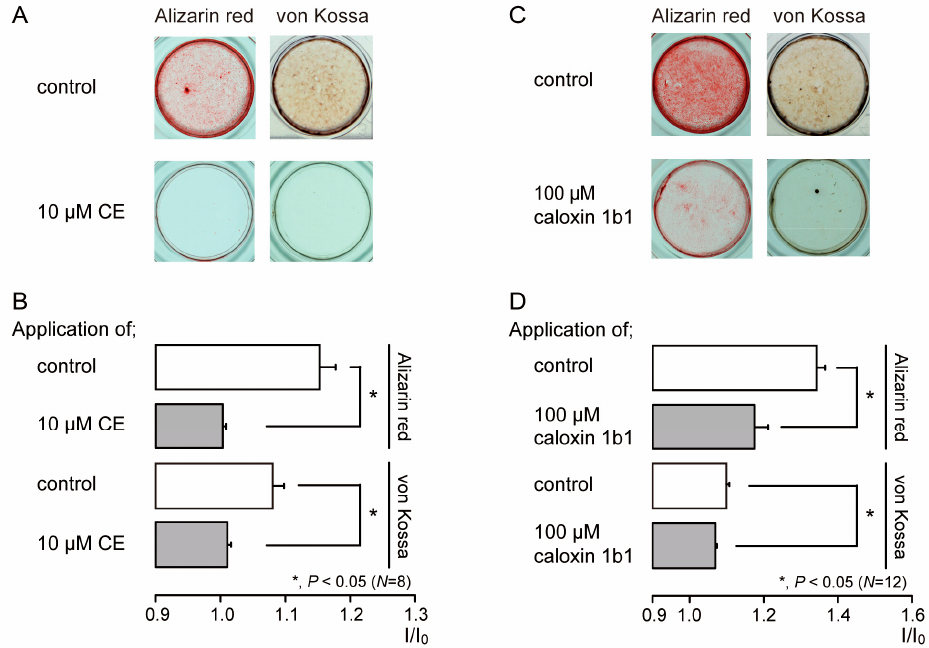
Figure 6. PMCA inhibitors decrease mineralization levels. ( A , C ) HOB cells were cultured for 28 days in mineralization medium with PMCA inhibitors (each lower column), 10 µM CE ( A ), or 100 µM caloxin 1b1 ( C ), or without them (each upper column in ( A , C )) at pH 7.4. Alizarin red (left columns; red indicative of calcium deposition) and von Kossa (right columns; black indicative of phosphate and calcium deposition) staining. ( B , D ) Mineralization levels with (gray columns) and without (open columns) PCMA inhibitors 10 µM CE ( B ) or 100 µM caloxin 1b1 ( D ), assessed by Alizarin red (upper columns), and von Kossa (lower columns) staining. Each column in ( B , D ) denotes the mean ± SE from 8 and 12 experiments, respectively. The mineralization levels in the absence of CE (as controls in ( B )) were 1.15 ± 0.03 I/I 0 with Alizarin red staining and 1.08 ± 0.02 I/I 0 units with von Kossa staining. The mineralization levels with CE (gray bars in ( B )) were 1.00 ± 0.01 I/I 0 units with Alizarin red staining and 1.01 ± 0.01 I/I 0 units with von Kossa staining. The mineralization levels without caloxin 1b1 (as controls in ( D )) were 1.34 ± 0.02 I/I 0 units with Alizarin red staining and 1.11 ± 0.01 I/I 0 units with von Kossa staining. The mineralization levels with caloxin 1b1 (gray bars in ( D )) were 1.18 ± 0.04 I/I 0 units with Alizarin red staining and 1.07 ± 0.01 I/I 0 with von Kossa staining. Statistically significant differences (in ( B , D )) between columns (shown by solid lines) are indicated by asterisks. * P < 0.05.